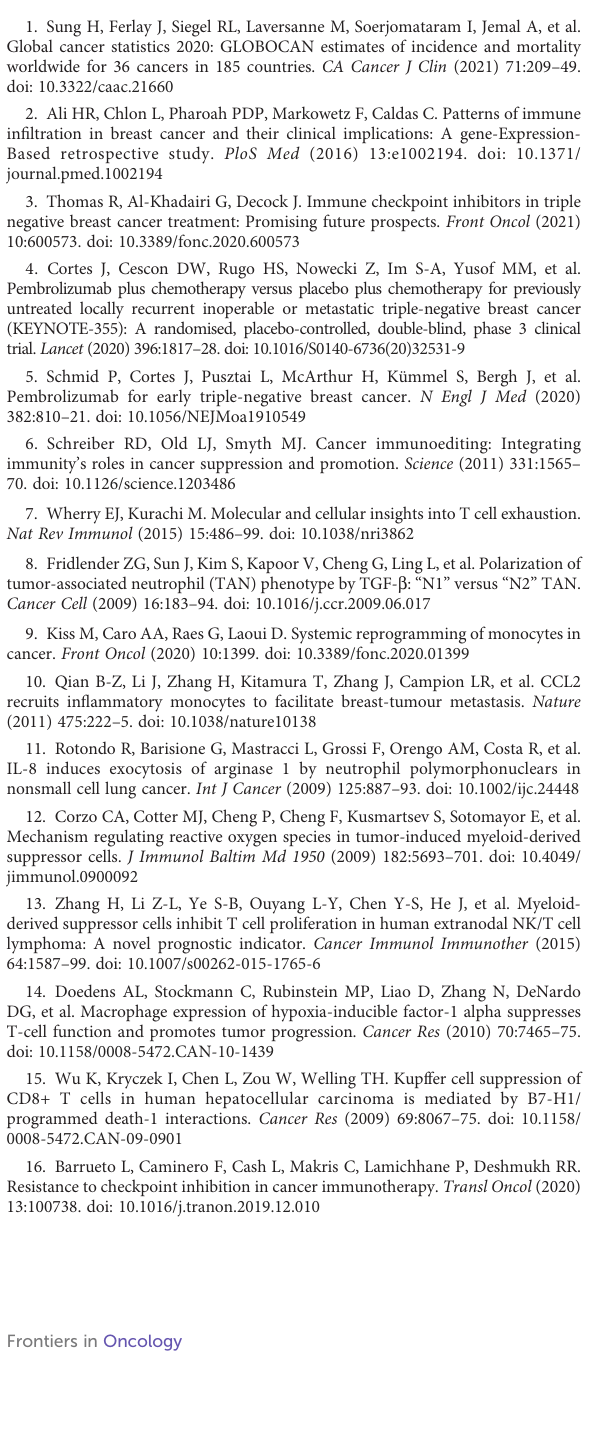
SUPPLEMENTARY FIGURE 2 NP administration does not alter the ratio of CTCs to white blood cells in 4T1 tumor-bearing mice (n=6 pergroup). (A) Quanti fi cation of the ratio of CTCs to white blood cells (WBCs). Cell quantities normalized to blood volume. (B) Representative images of cells isolated from peripheral blood. Blue – DAPI, Green – CD45+, Red – tdTomato. SUPPLEMENTARY FIGURE 3 Gene expression pro fi les of lung-derived cell populations by single cell RNA sequencing. (A) Marker genes used to identify immune cell clusters. Gene expression of (B) neutrophils, (C) dendritic cells, and (D) monocytes used to identify subpopulations.